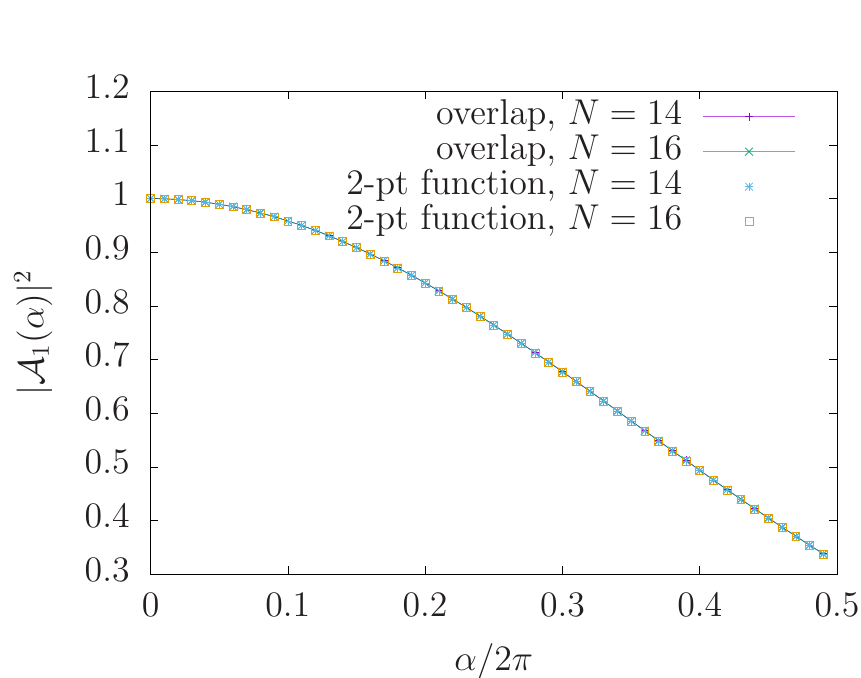
( α ) as a function of α , for the XXZ spin chain with ∆ = 0.4 Figure 4: The coefficient A 1 ( α ) | 2 is obtained from the and system sizes of N = 14,16 sites. The quantity | A 1 overlap (3.46), or from the two-point function (3.74). The agreement between the two determinations is very good.